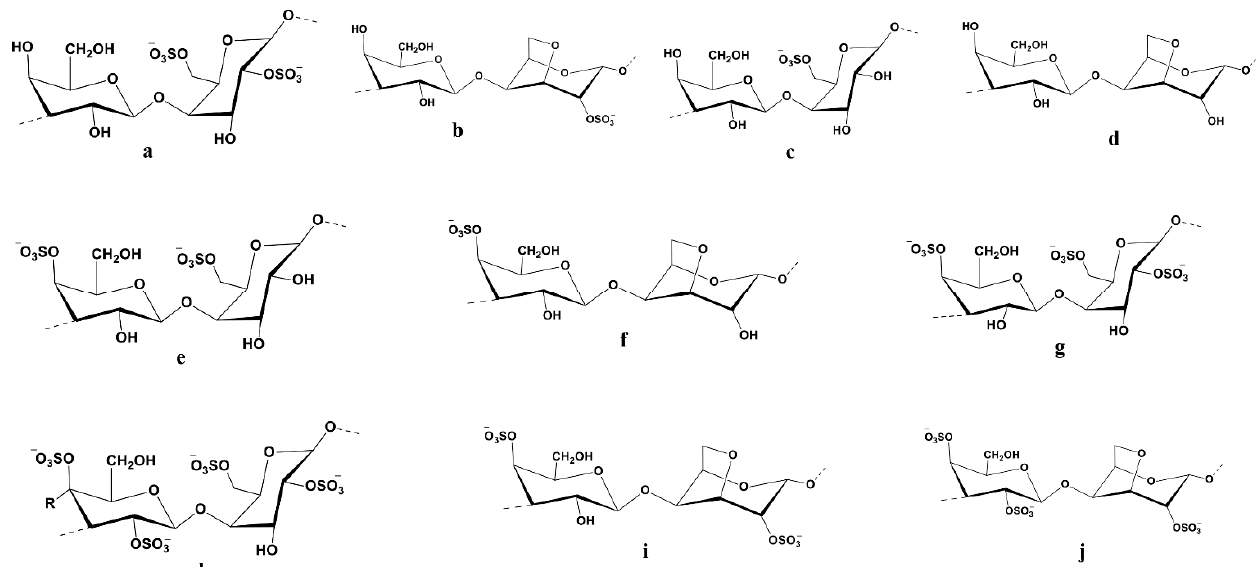
Figure 5. The Molecular structure of different types of carrageenan with potential therapeutic effects are drawn in Chemdraw 12.0 Ultra. The Polymeric structures of the different molecular structures of carrageenan as ϒ -carrageenan ( a ); β -carrageenan ( b ); δ -carrageenan ( c ); α -carrageenan ( d ); µ-car- rageenan ( e ); κ -carrageenan ( f ); ν -carrageenan ( g ); ι -carrageenan ( h ); λ -carrageenan ( i ); and ϴ -car- rageenan ( j ).